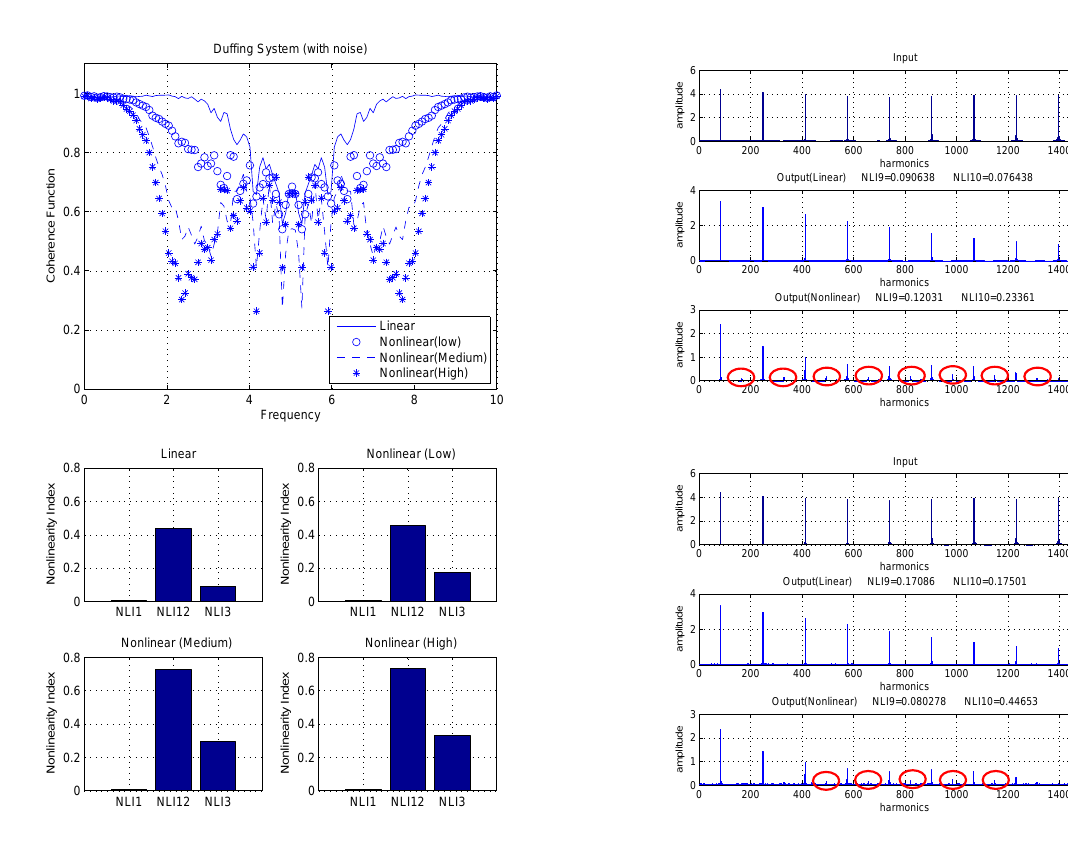
Figure 5: New harmonics generation of Duffing system in linear and nonlinear modes with a multi harmonic excitation signal and Top. with- out measurement noise. Bottom. with mea- surement